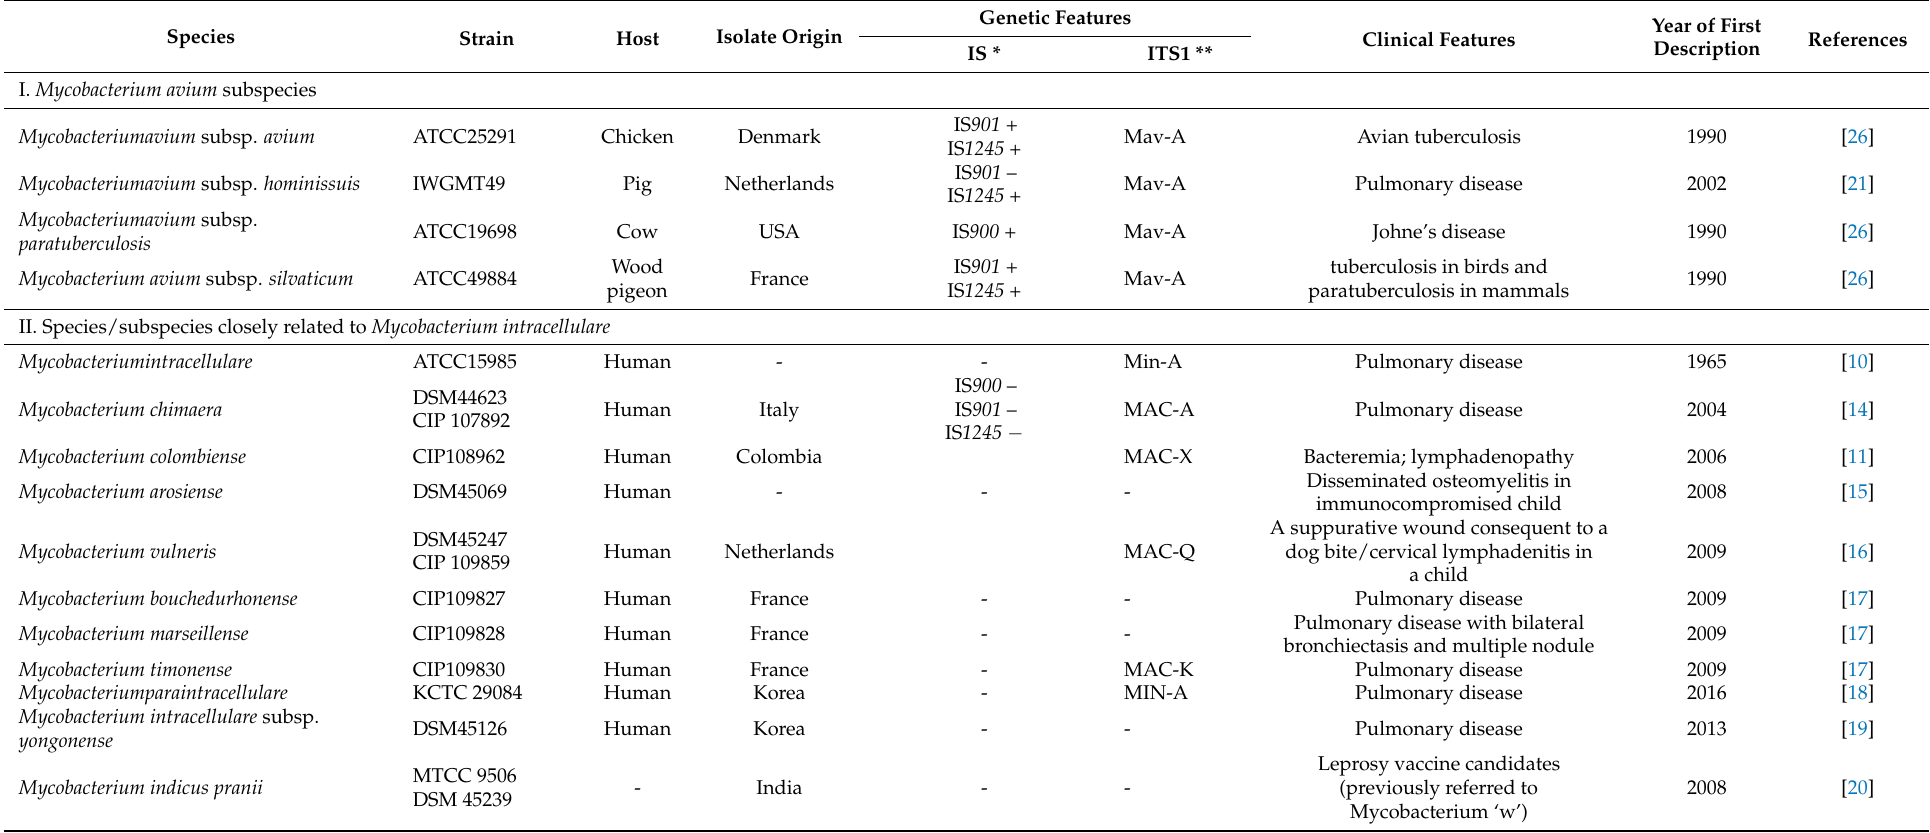
Table 1. Genetic makers and clinical features of the representative strains in MAC